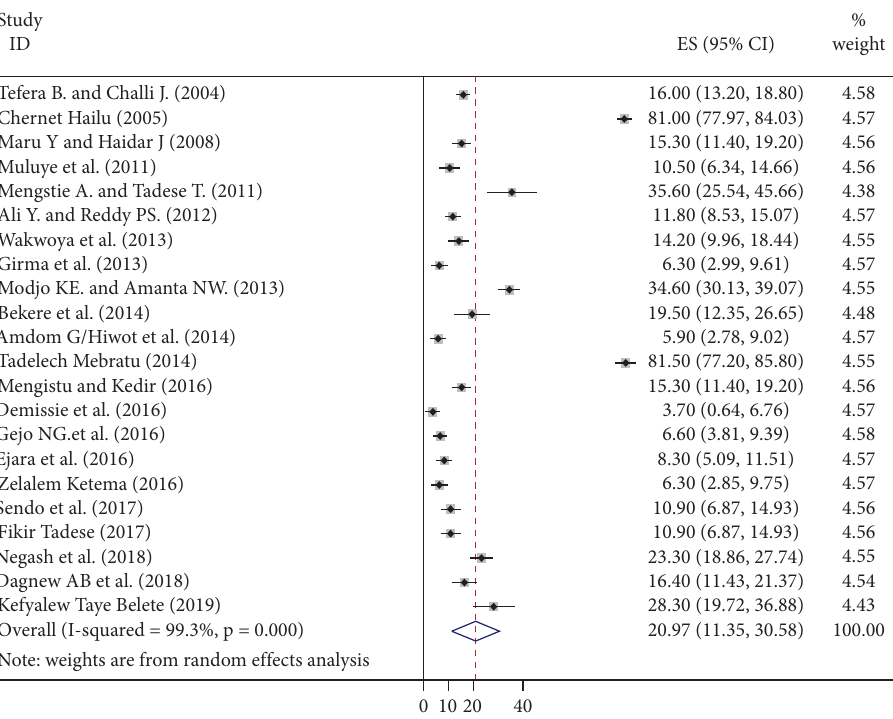
analysisOverall Note: weights are from random effects Figure 3: Forest plot showing the pooled prevalence of replacement feeding practice of HIV-exposed infants in